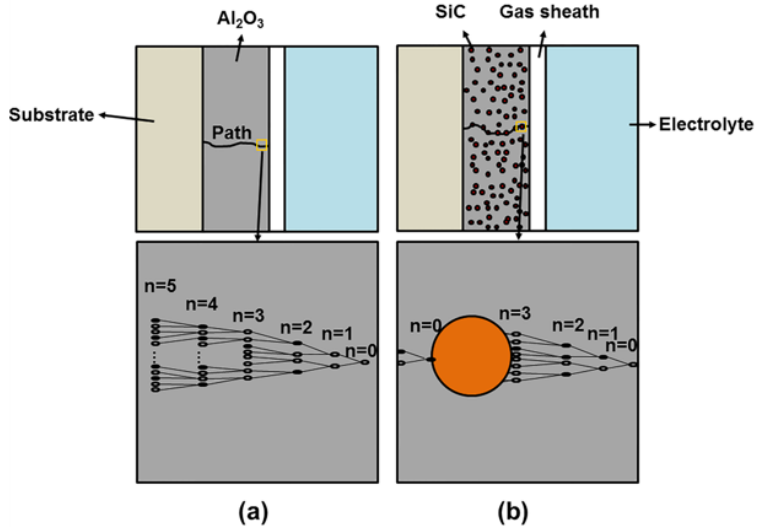
Figure 14. Electronic avalanche model diagram: ( a ) Al 2 O 3 coating; ( b ) Al 2 O 3 –SiC composite coat- ing.